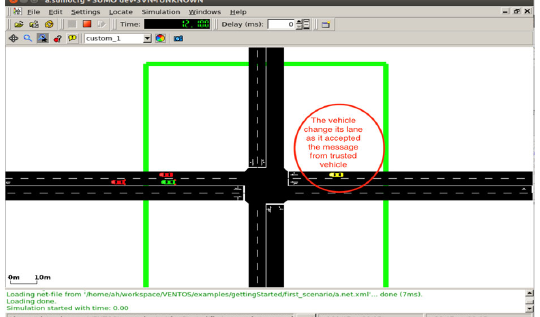
Fig. 14. Scenario 3: The Incoming Vehicles will receive the Message and Accept or Ignore the Message Based on